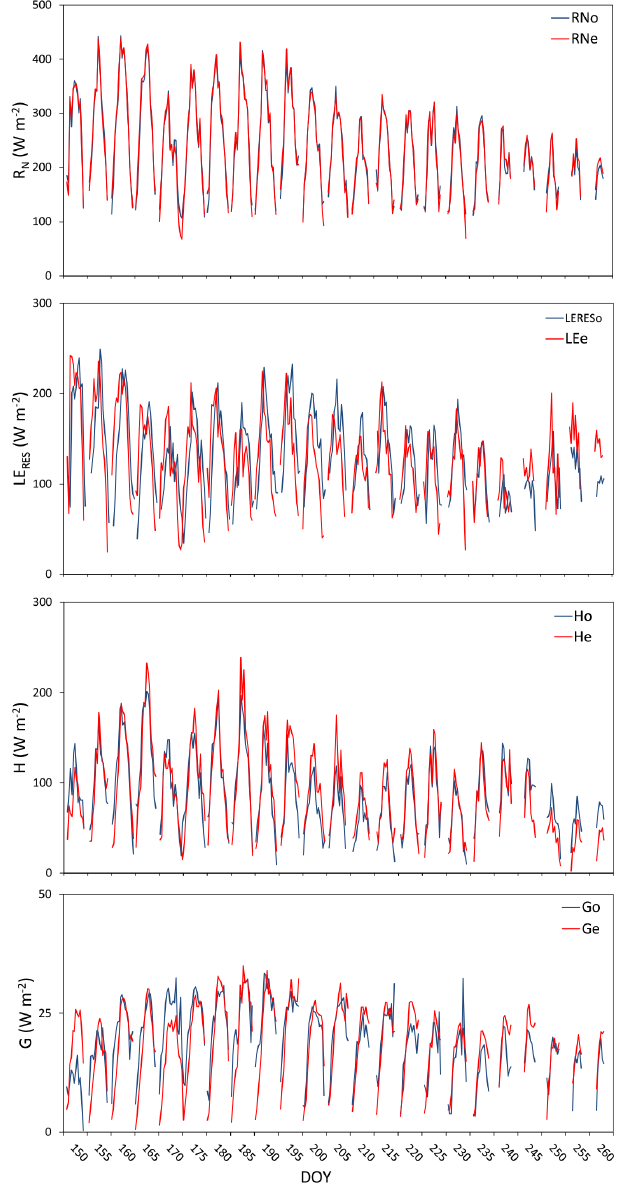
Figure 7. Comparison of hourly flux tower RN, LE, H and G observations (using LE from residual closure) ( o ) (from 06:00 to 21:00LST) at the Heath flux tower with model estimates ( e ) using α PTC of 0.92. Each diurnal segment represents flux data averaged by hour over 5-day intervals from 2008 to